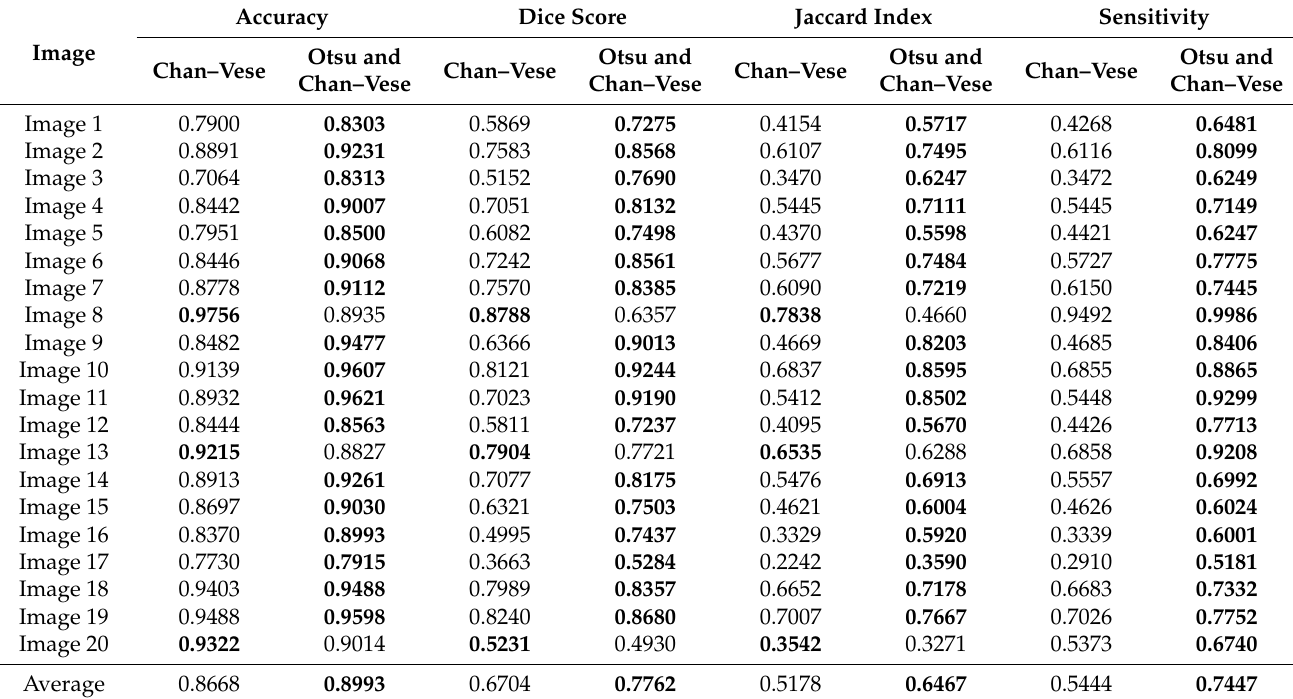
Table 1. Comparison of the accuracy, Dice Score and Jaccard index for the classical Chan–Vese and proposed